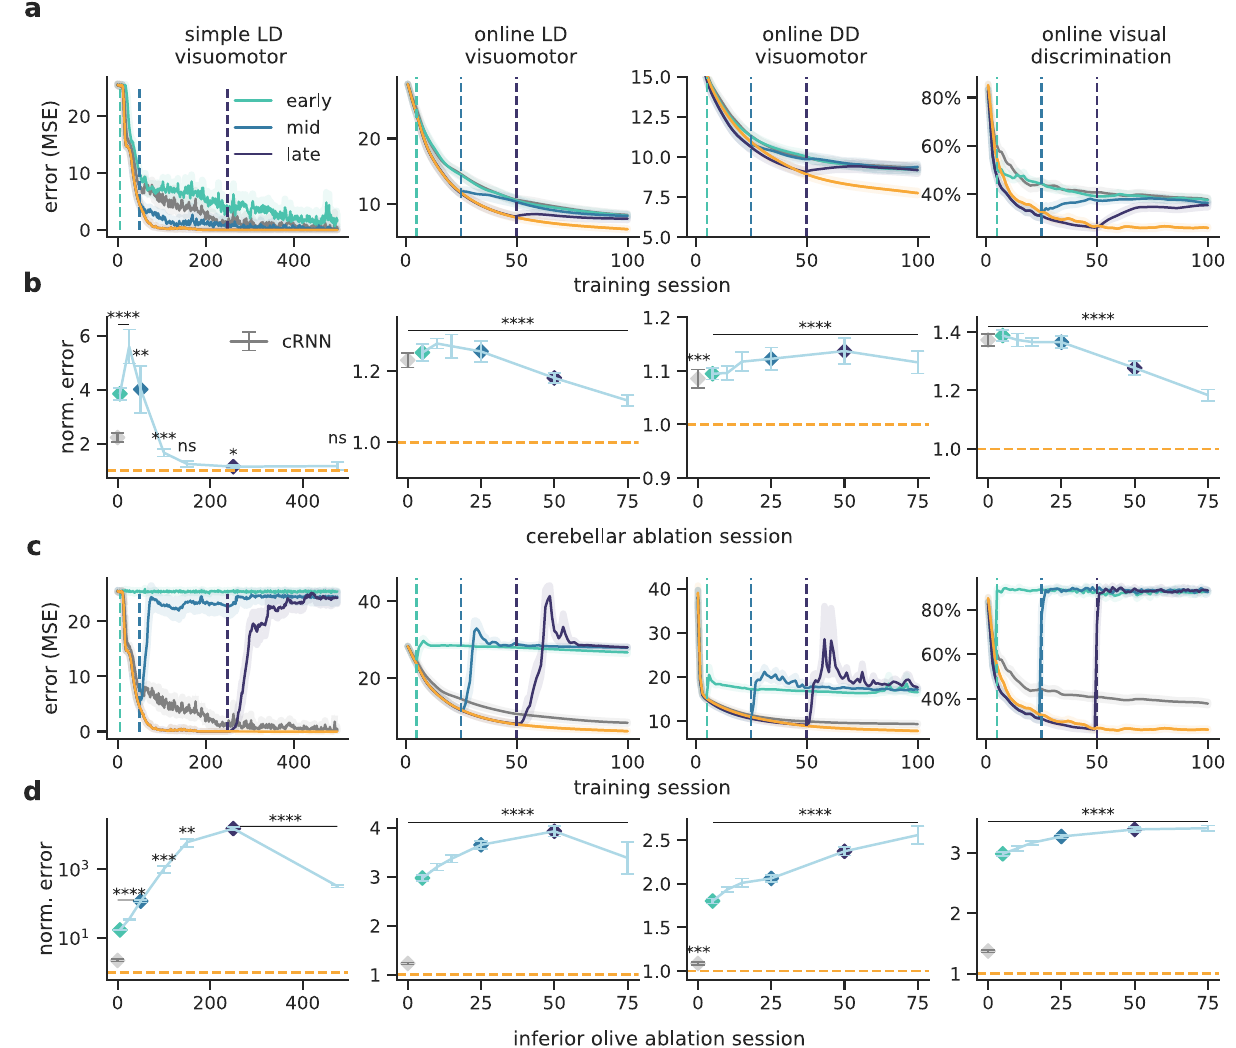
Fig. 7 | Inactivating cerebellar output and inferior olive have a differential impact on learning. a Complete cerebellar lesion at different points during learning.Verticallinesrepresentatwhichpointduringtraining thecerebellumwas inactivated in the ccRNN model. In gray and orange are shown the baseline per- formances of the cerebral RNN and ccRNN, respectively. b Normalised error after cerebellar lesion throughout learning with respect to ccRNN (ns denotes not sig- ni fi cant: simple LD visuomotor p =0.062 (session 150), p =0.162 (session 475)). Gray denotes normalised error for cRNN. c Complete inferior-olive lesion at